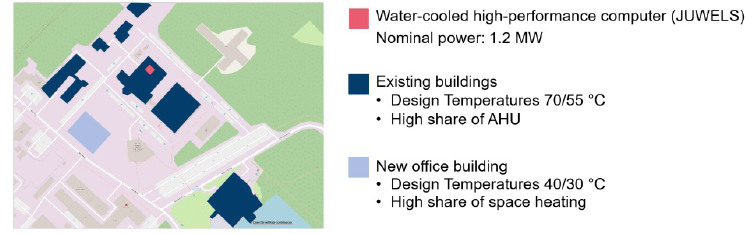
Figure 5. Layout of low-temperature district heating